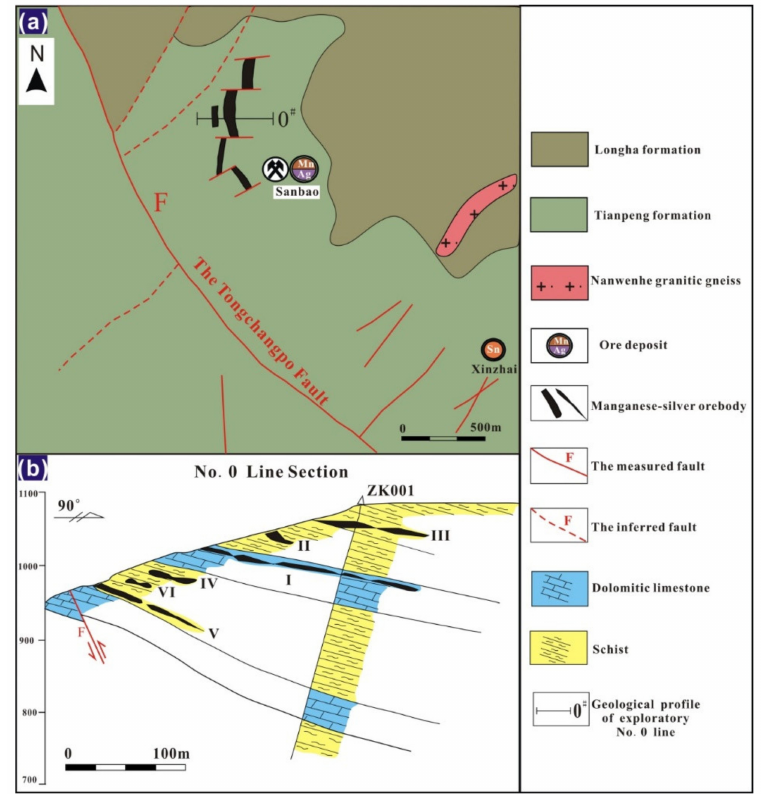
Figure 2. ( a ) Simplified geologic map of the Sanbao Mn–Ag deposit; and ( b ) cross-section of exploration line 0 (modified from [8]). Table 1. Details of the Tianpeng Formation from the Sanbao deposit. Layer